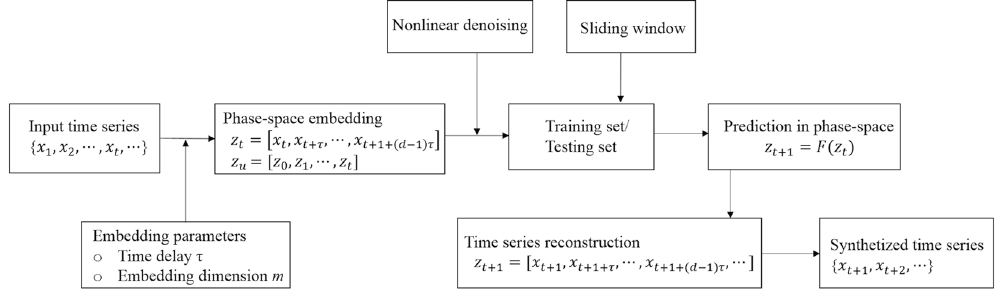
Figure 3. Main steps of time series